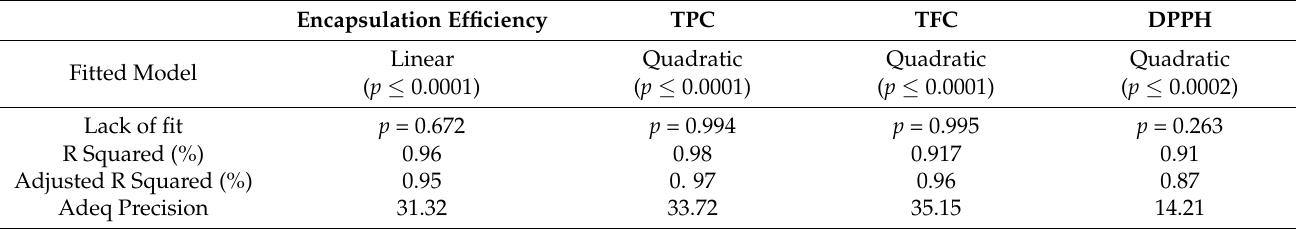
Table 5. Regression models for chemical parameters of onion